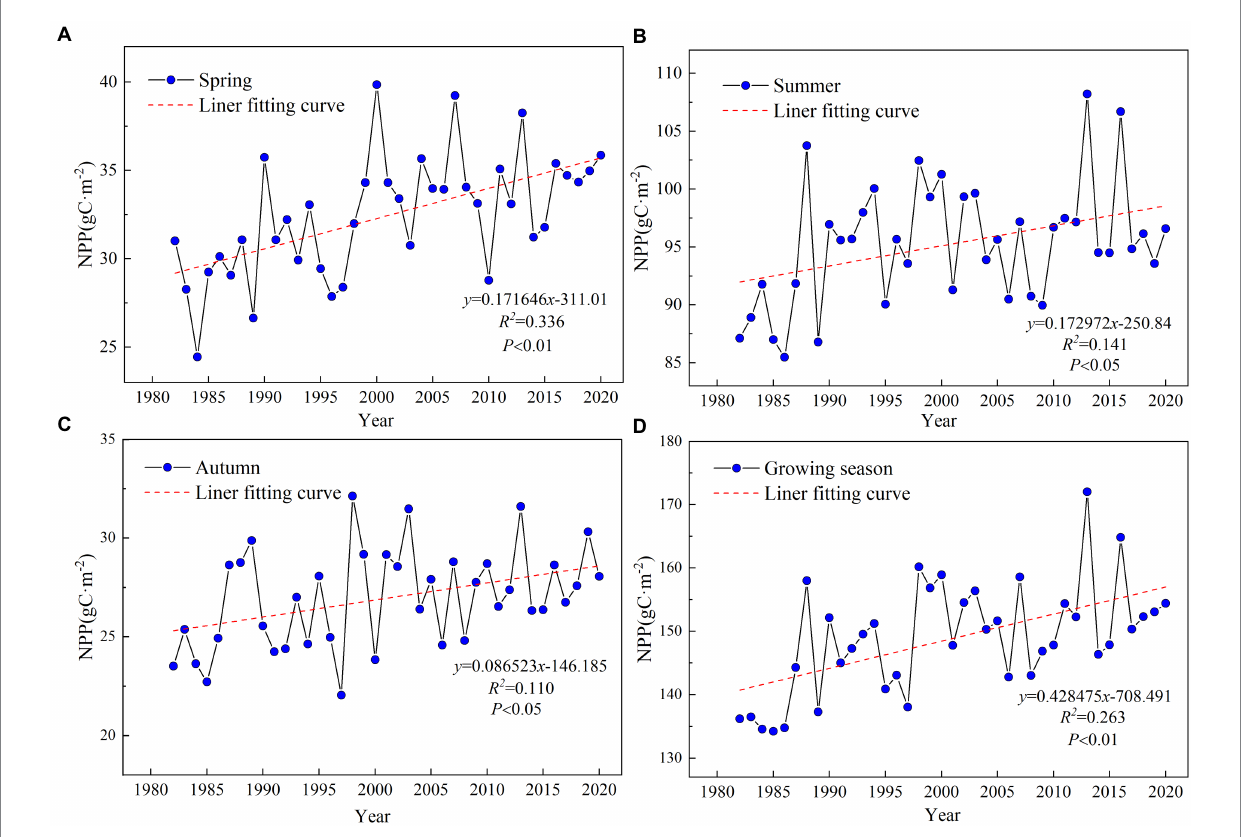
FIGURE 3 The NPP during the (A) spring, (B) summer, (C) autumn, and (D) growing season for the period from 1982 to 2020.